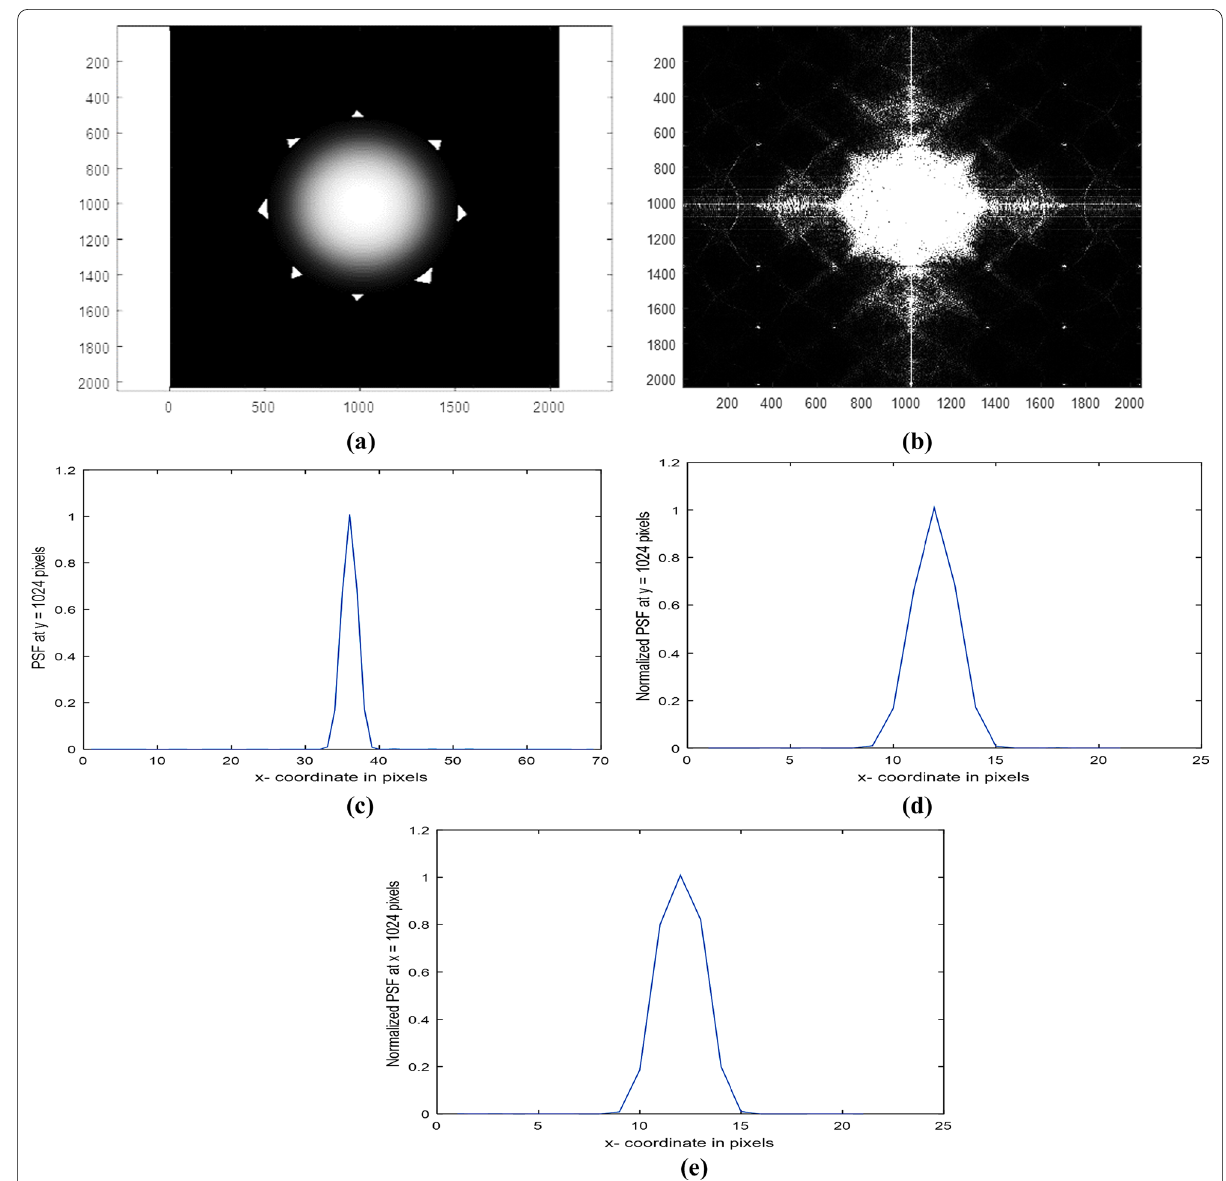
Fig. 5 a Circular aperture of linear distribution with 8 spikes in a matrix of dimensions 2048 The PSF image or intensity impulse response is corresponding to the aperture shown in ( a ). c : The Normalized PSF plot in the range from 990 up to 1058 pixels is corresponding to the image shown in ( a ). It is shown that the central peak is found at 36 pixels. d : The Normalized PSF plot in the range from 1014 up to 1034 pixels at y 1024 pixels is corresponding to the image shown in ( a ). e : The Normalized PSF plot in the range from 1014 = up to 1034 pixels at x 1024 pixels is corresponding to the image shown in ( a =